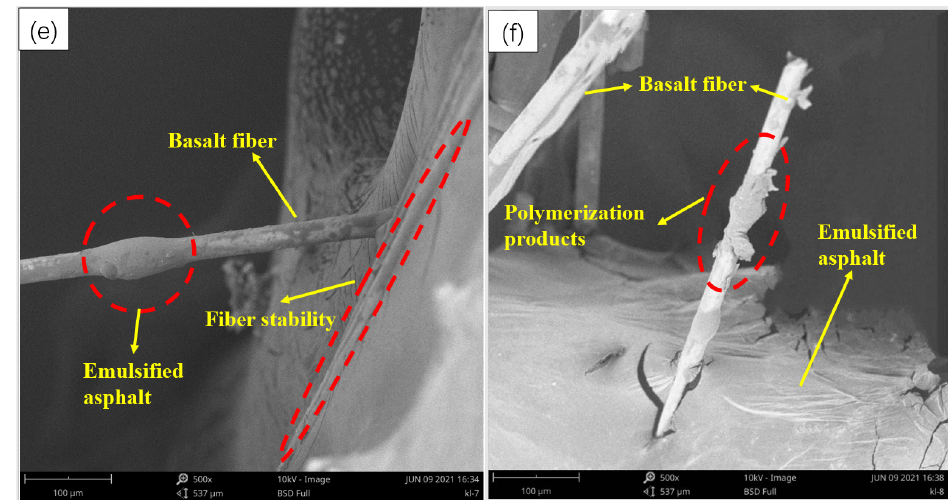
Figure 18. Microstructure of fiber-emulsified asphalt: ( a ) fiber bridging effect; ( b ) fiber stabilization effect; ( c ) fiber adsorption effect; ( d ) fiber reinforcement effect; ( e ) latex bead; ( f ) modified fiber polymerization product.